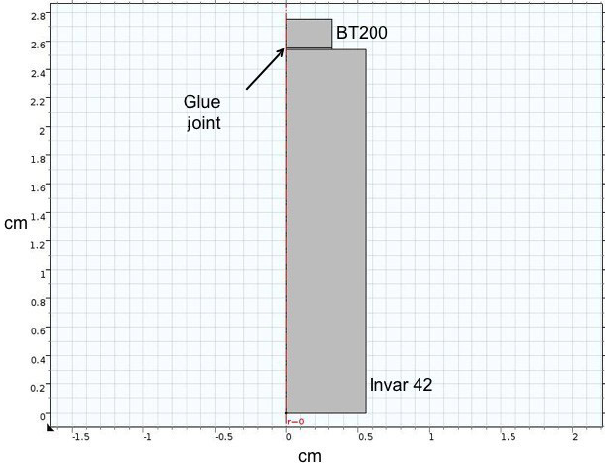
Figure 7. The COMSOL mesh diagram of the system’s